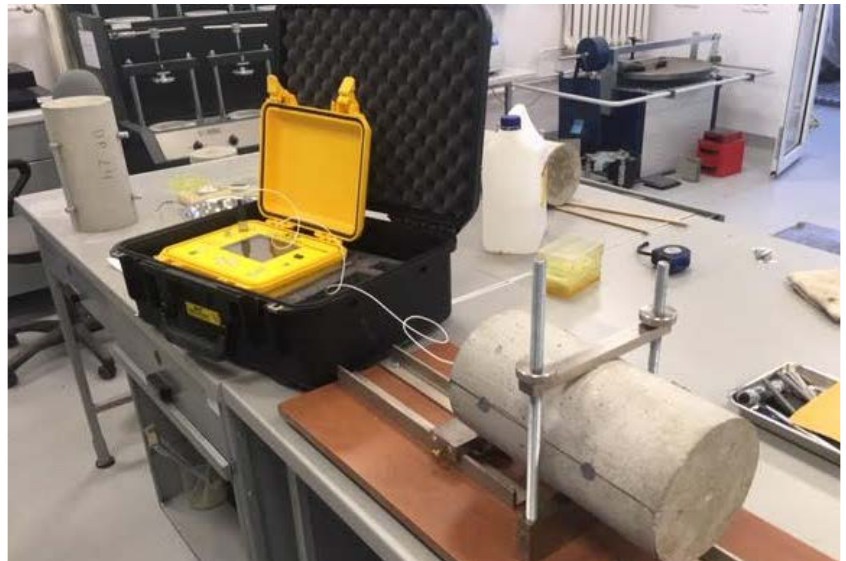
Figure 5. Resonance testing of the modulus of elasticity.